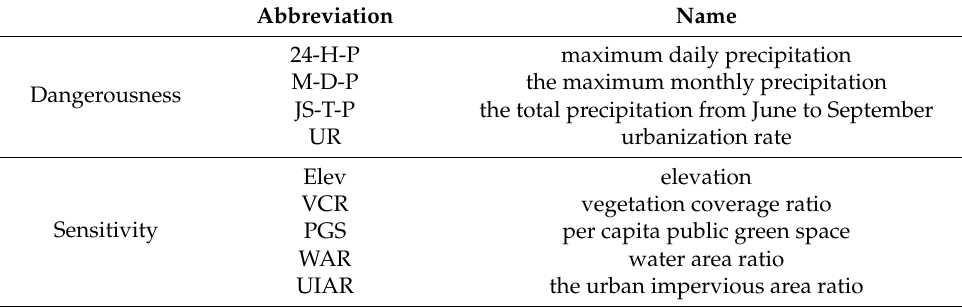
Table 1. The indicator system of rainstorm disaster risk